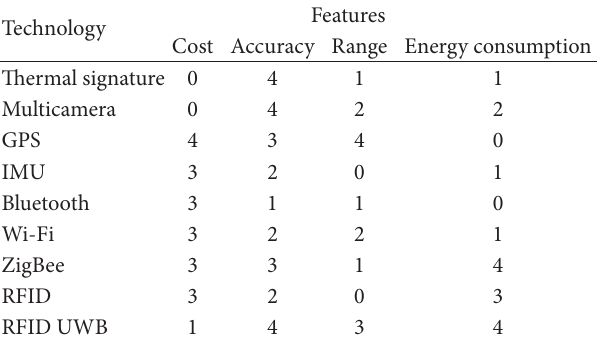
Table 1: Comparison between different tracking